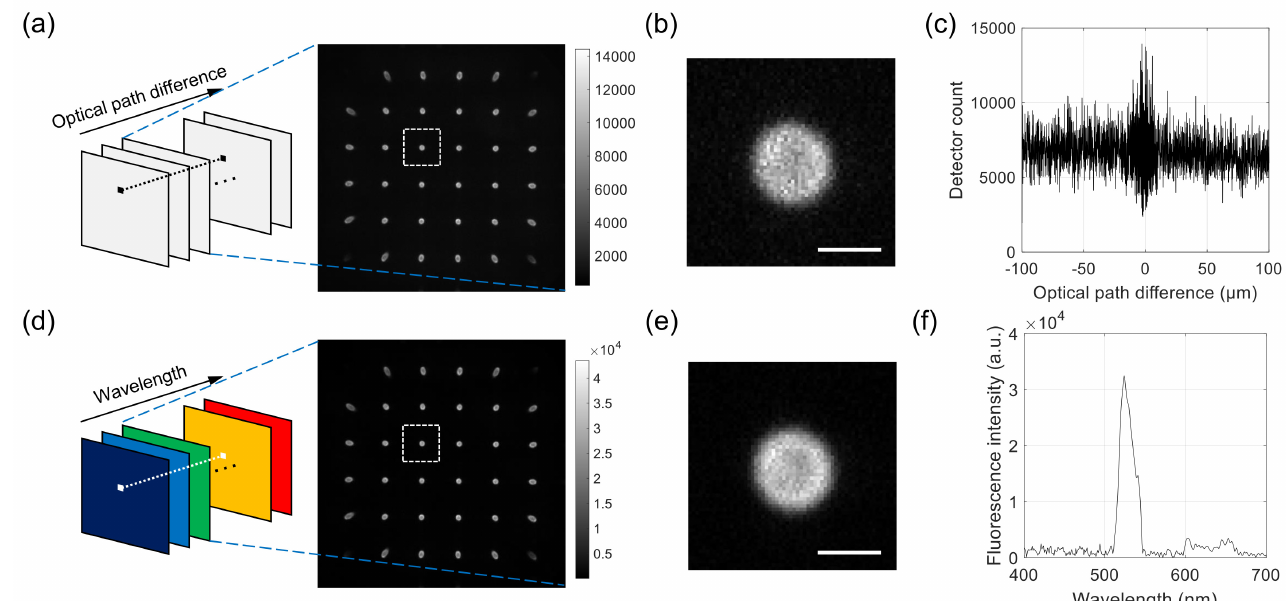
Figure 2. Example raw images acquired with the developed system and Fourier-transform spectroscopy (FTS) data processing. ( a – c ) For a 6 µ m fluorescent bead, a series of interferogram images is acquired for different optical path differences. Each image consists of a multitude of projection images, as shown in the extracted image on the right. ( b ) shows a magnified image of the rectangular region in ( a ), and ( c ) shows the intensity of interferogram at the center of bead. ( d – f ) From the raw images in Figure 2a, a series of hyperspectral images ( a ) is calculated. The extracted image on the right corresponds to the wavelength of 530 nm. ( e ) shows a magnified image of the rectangular region in ( d ), and ( f ) shows the intensity of reconstructed spectrum at the center of the bead. Scale bars in ( b , e ): 5 µ